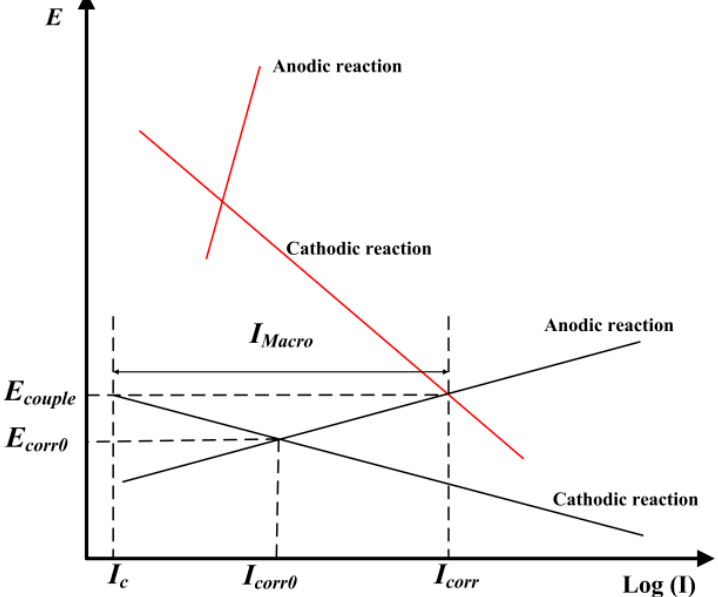
Figure 9 Schematic Evan’s Diagram illustrating the I corr , I Macro , I corr 0 , and I c